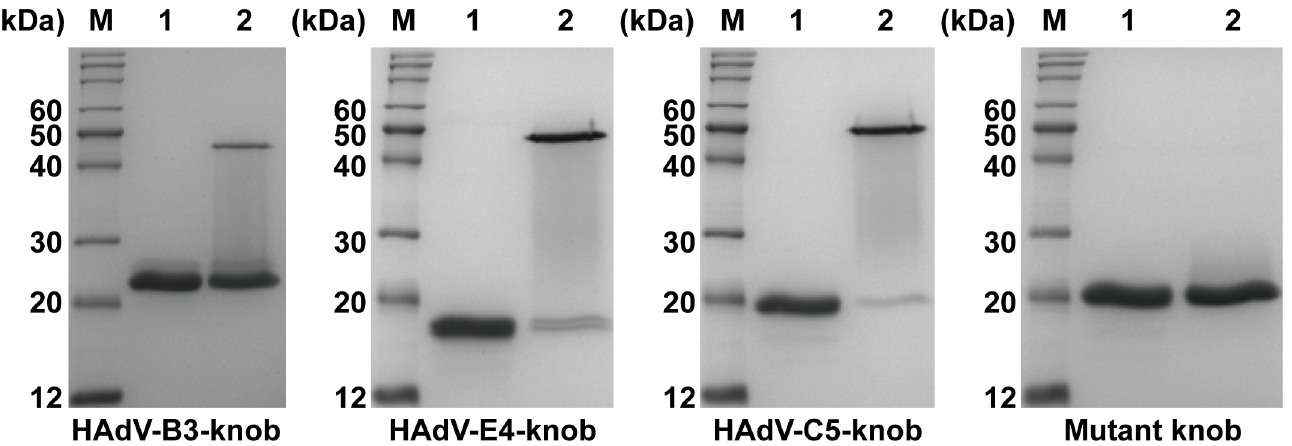
Fig 2. SDS-PAGE analysis of the purified knob proteins. The purified knob proteins of HAdV-B3, E4, and C5 and the mutant knob protein with and without preheating (lanes 1 and 2, respectively) were individually analyzed by SDS-PAGE under denaturing and reducing conditions. Coomassie Brilliant Blue staining of the purified knob proteins of HAdV-B3, E4 and C5 and the mutant knob protein with preheating revealed bands corresponding to the expected molecular weight of the monomeric proteins (23 kDa, 18 kDa, 20 kDa and 20 kDa, respectively). The purified knob proteins of HAdV-E4 and C5 without preheating were revealed in polymeric form, while the purified knob protein of HAdV-B3 and the mutant knob protein without preheating were revealed in monomeric form. Lane M represents the protein marker.